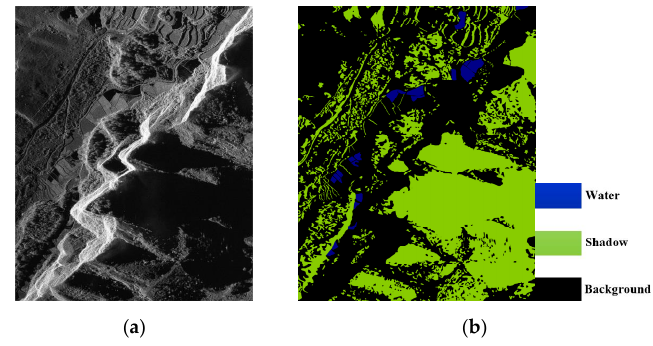
Figure 15. The second experiment data. ( a ) SAR image. ( b ) Ground truth.